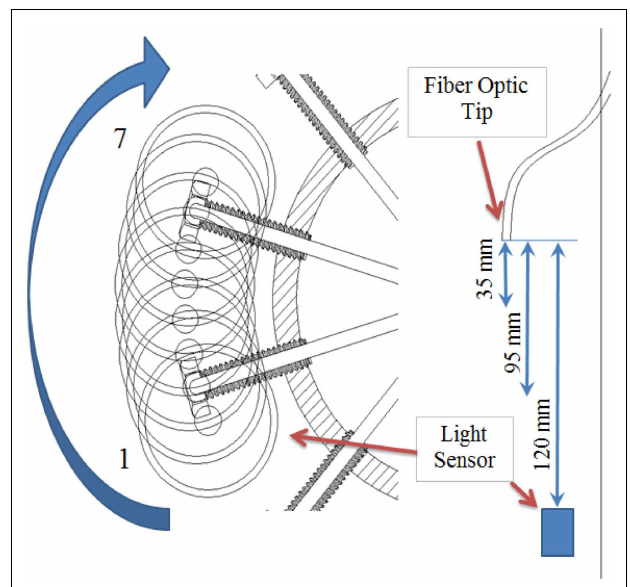
FIGURE 4 | Light characterization among fibers in the air-lift photobioreactor .